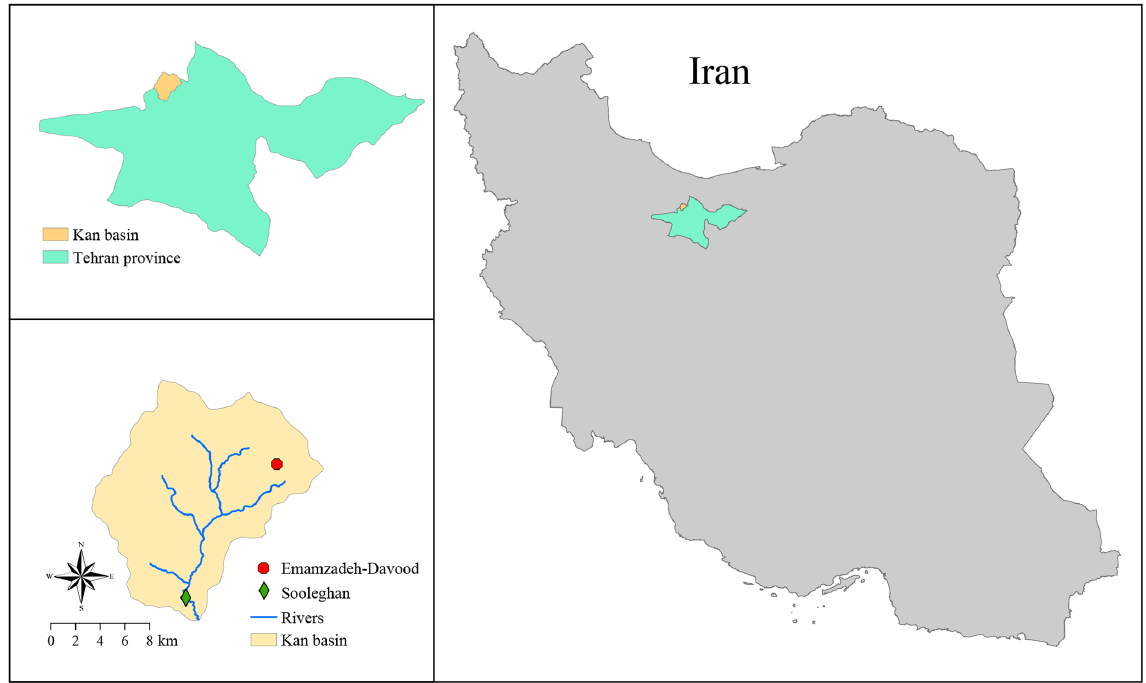
Figure 1. Location of study area, rainfall and flow stations.